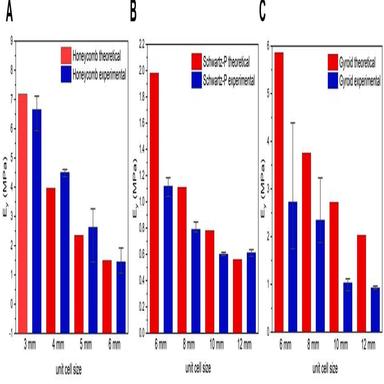
Comparison among theoretical and experimental Young's Moduli of the analyzed structure: (A) honeycomb, (B) schwartz-P, and (C) gyroid. According to the selected testing direction, the theoretical values are the Ey provided in.